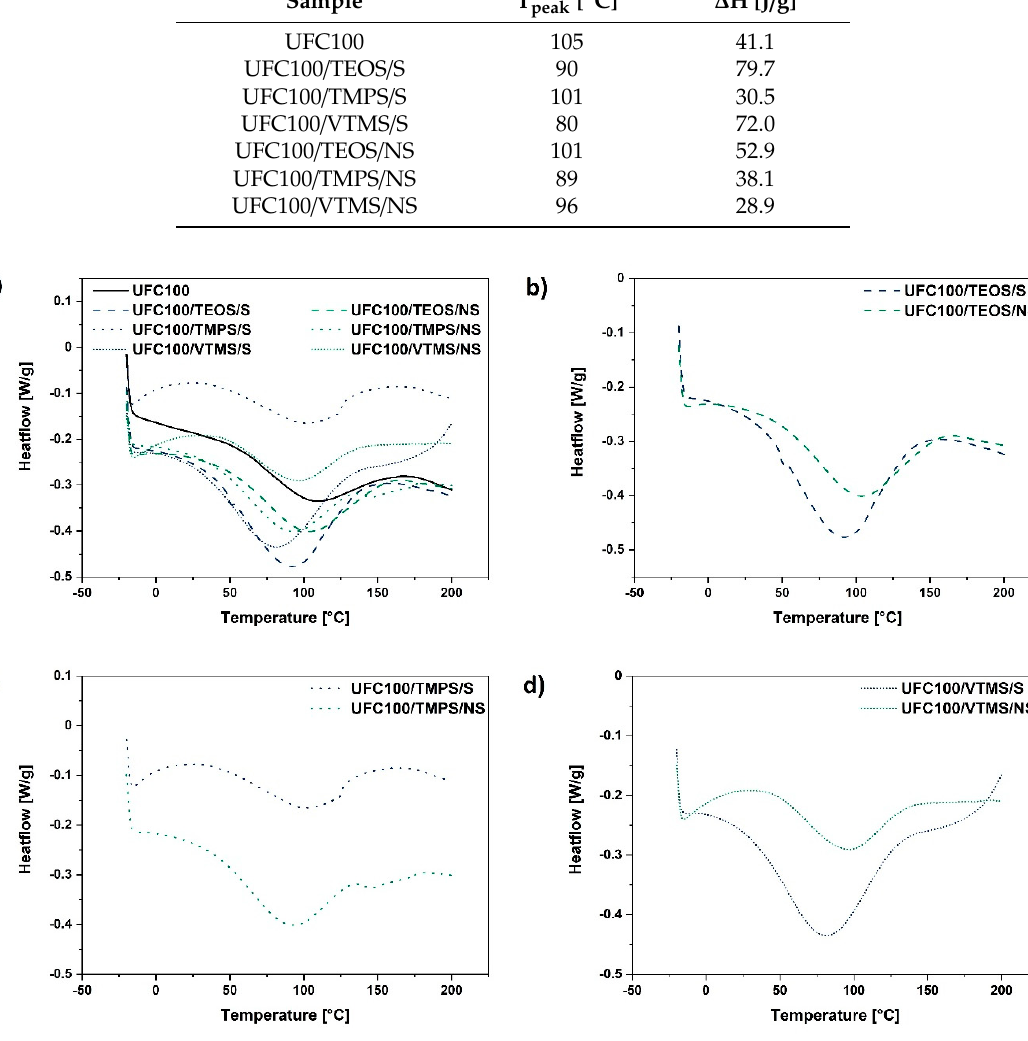
Figure 5. Differential scanning calorimetry curves of: a ) all analysed cellulose samples treated via Figure 5. Di ff erential scanning calorimetry curves of: ( a ) all analysed cellulose samples treated different methods (solvent-involving/non-solvent); b ) cellulose specimens modified with TEOS; c ) via di ff erent methods (solvent-involving / non-solvent); ( b ) cellulose specimens modified with TEOS; cellulose specimens modified with TMPS; d ) cellulose specimens modified with VTMS. ( c ) cellulose specimens modified with TMPS; ( d ) cellulose specimens modified with